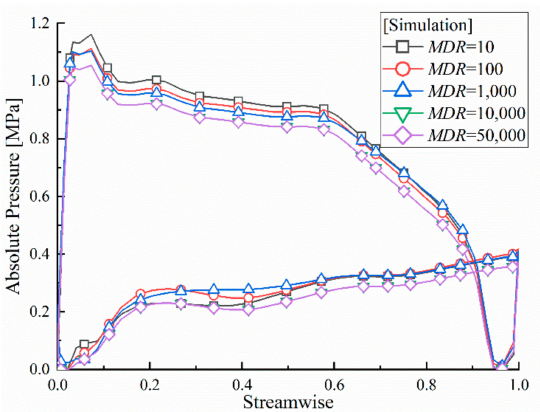
Figure 32. Absolute pressure on stator blade at stall under various maximum density